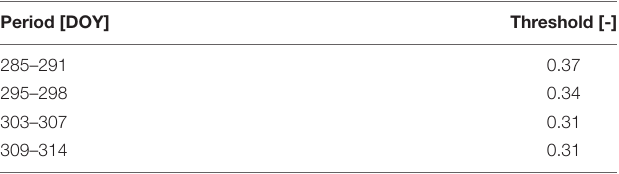
TABLE 1 | NDVI thresholds for the four periods based on a reference pixel analysis of Landsat 5, 7, and 8. Period [DOY]